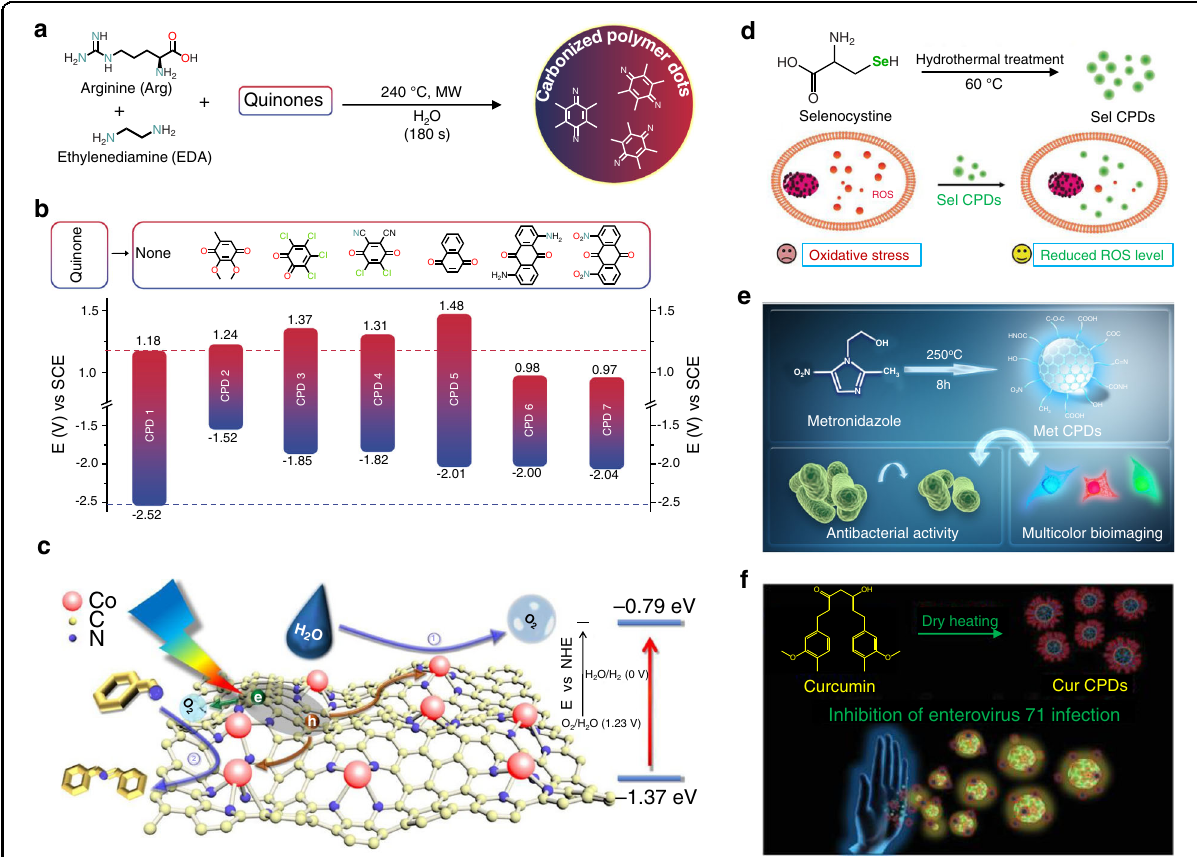
Fig. 3 Precursor-dominated versatile functions. a Synthesis of CPDs from Arg, EDA, and quinones. b Corresponding redox potentials of CPDs. c Single Co atom anchored in CPDs derived from VB12 for photocatalysis. d Sel-CPDs (exhibiting green fl uorescence) synthesized by hydrothermally treating selenocystine, which can be used as an ROS scavenger. e Met CPDs exhibiting blue fl uorescence and selective antibacterial activity against Porphyromonas gingivalis. f Curcumin CPDs and their use as antiviral agents. Reprinted with permission from literature reports 16,56 – 59 .